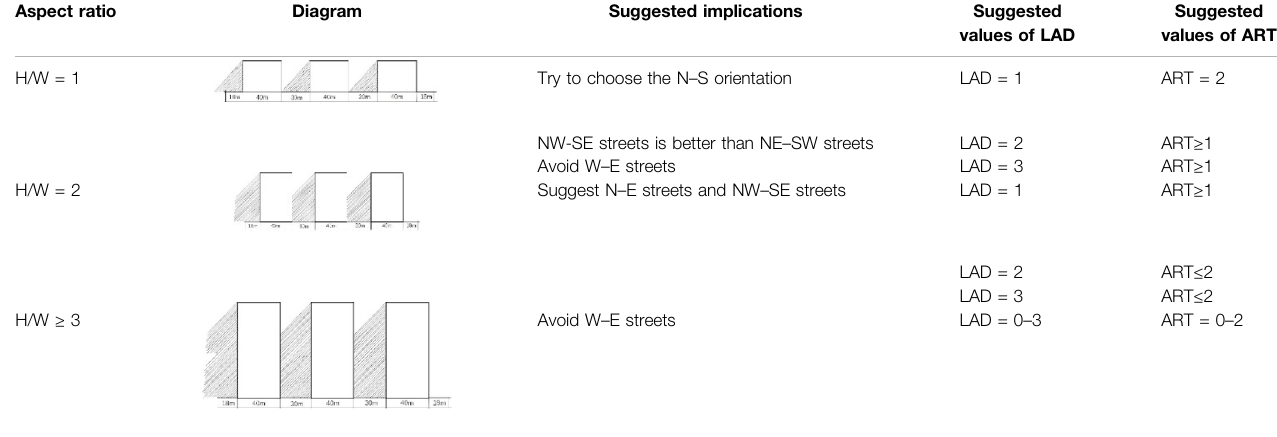
Suggested values of LAD values of